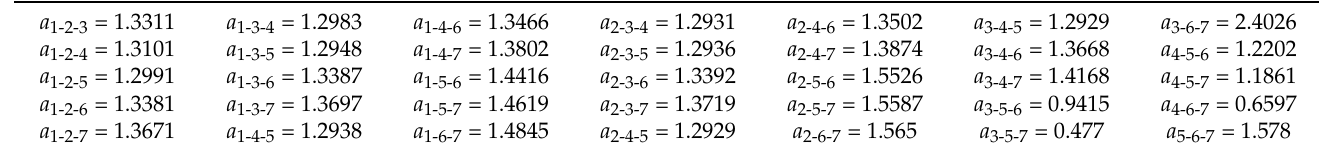
Table 9. The set of a r - s - t values of the probable theoretical elastic deformation at the compression, bending and torsion of a pole with double arm in the console determined based on k = 7 FEA analyses with different discretization levels (in